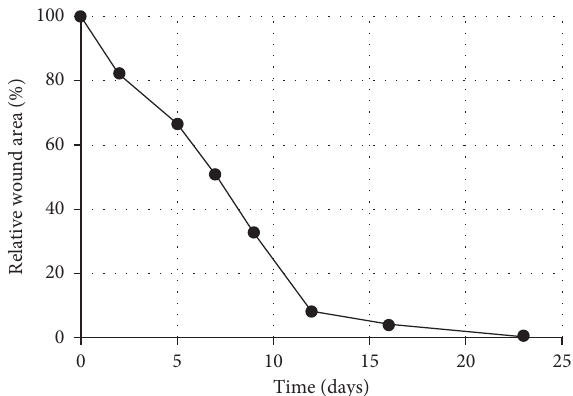
Figure 3: Relative wound closure in time, as quantified using ImageJ in relation to the wound area at the start of L-Mesitran Foam